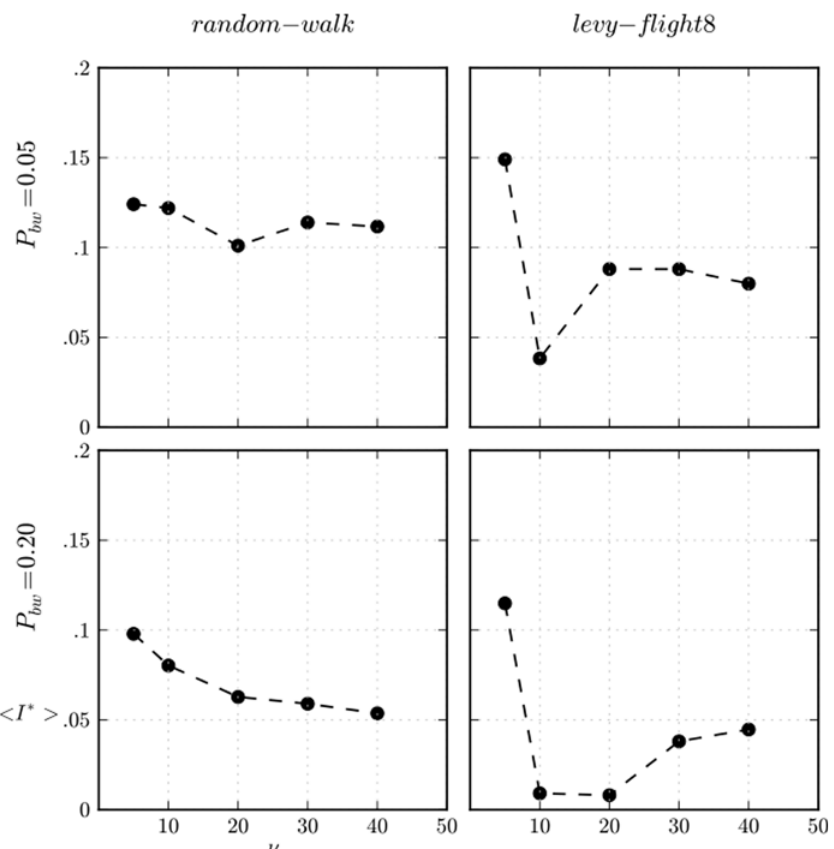
Fig 9. Public-private discrepancy in the imitations. Public-private discrepancy in the imitations for two values of P bw , and “ random-walk ” and “ Lévy-flight8 ” movements, measured as the average imitations I * over a complete simulation run in which there was any discrepancy between the public and the private strategies of the agent imitated. The spatial distributions of beached whales is uniform and θ = 10 – 1 . 5